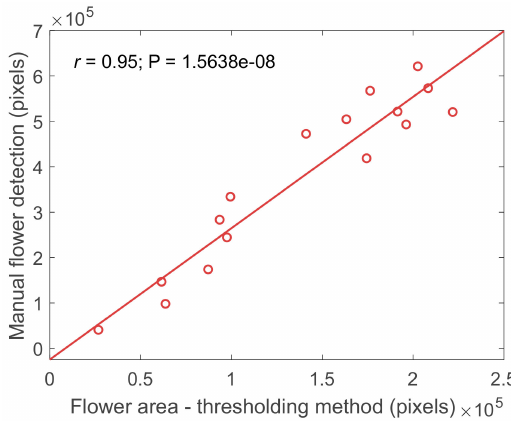
Figure 5. Correlation between flowers detected by thresholding method and manual identification. Table 4. Correlation coe ffi cient between features extracted from remote sensing data and visual rating scores on